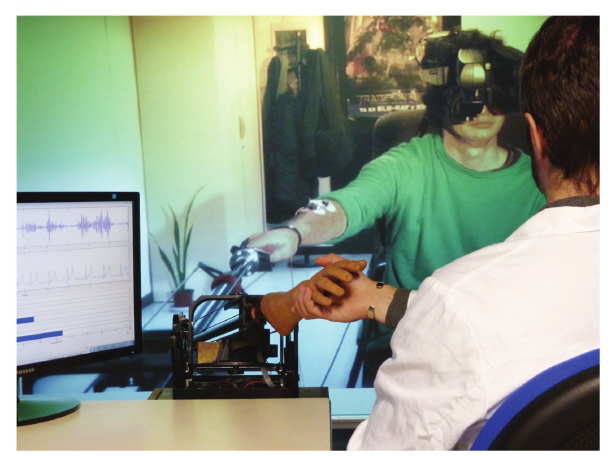
FIGURE 5 |The doctor’s office. At the current set-up, the patient is displayed in a life-sized screen. A haptic device with force-feedback is used for tactile interaction with the patient. A PC screen is used for monitoring patient’s physiological